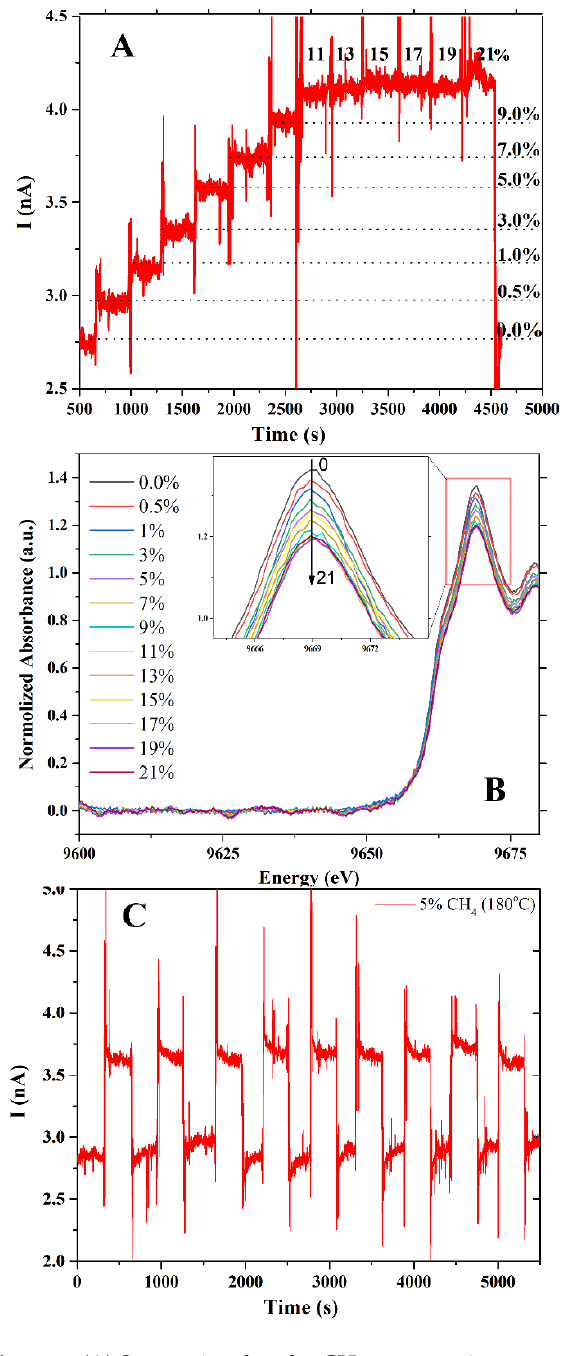
Figure 6. ( A ) Sensor signal under CH 4 gas at various concentrations, ( B ) the normalized Zn K-edge XANES of ZnO film and ( C ) nine consecutive